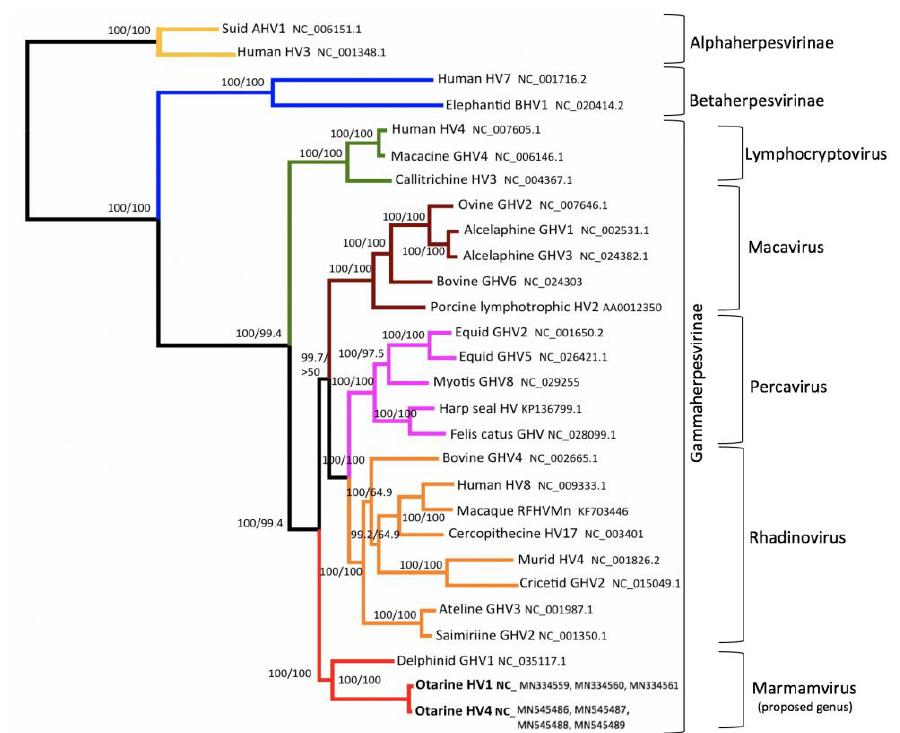
Figure 2. Bayesian analysis phylogram based on 4 concatenated herpesvirus core genes (polymerase, terminase, glycoprotein B, and major capsid protein) using predicted amino acid sequences. Bayesian posterior probabilities of each branch are expressed as % ( top ) and maximum likelihood (ML) bootstrap values as % ( bottom ). The 100%/100% values. Branch color is based on grouping herpesvirus subfamilies (yellow-Alphaherpesvirinae, blue-Betaherpesvirinae) and genera (green-lymphocryptoviruses, maroon-macaviruses, pink-percaviruses, orange-rhadinoviruses, and red- proposed genus Marmamvirus). Otarine HV1, Otarine HV4 and Delphinid GHV1 branch form a clade distinct from other known gammaherpesvirus